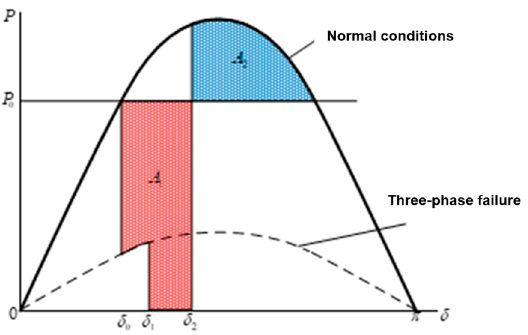
Figure 1. Effect of a three-phase opening and reclosing using the equal area criteria.